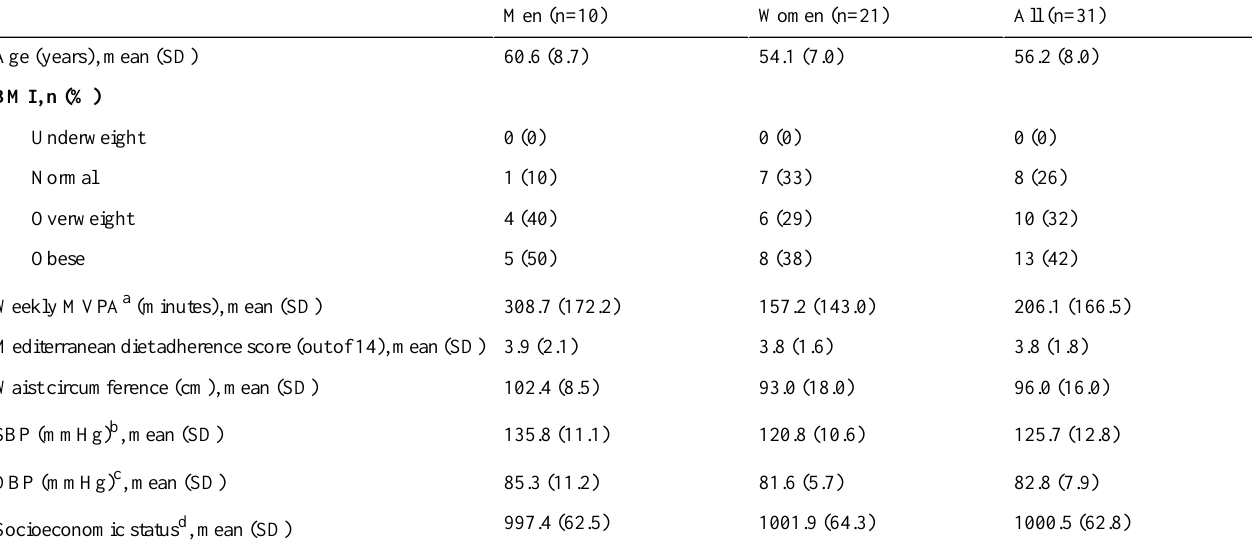
Table 1. Baseline characteristics of participants in the MedLiPal